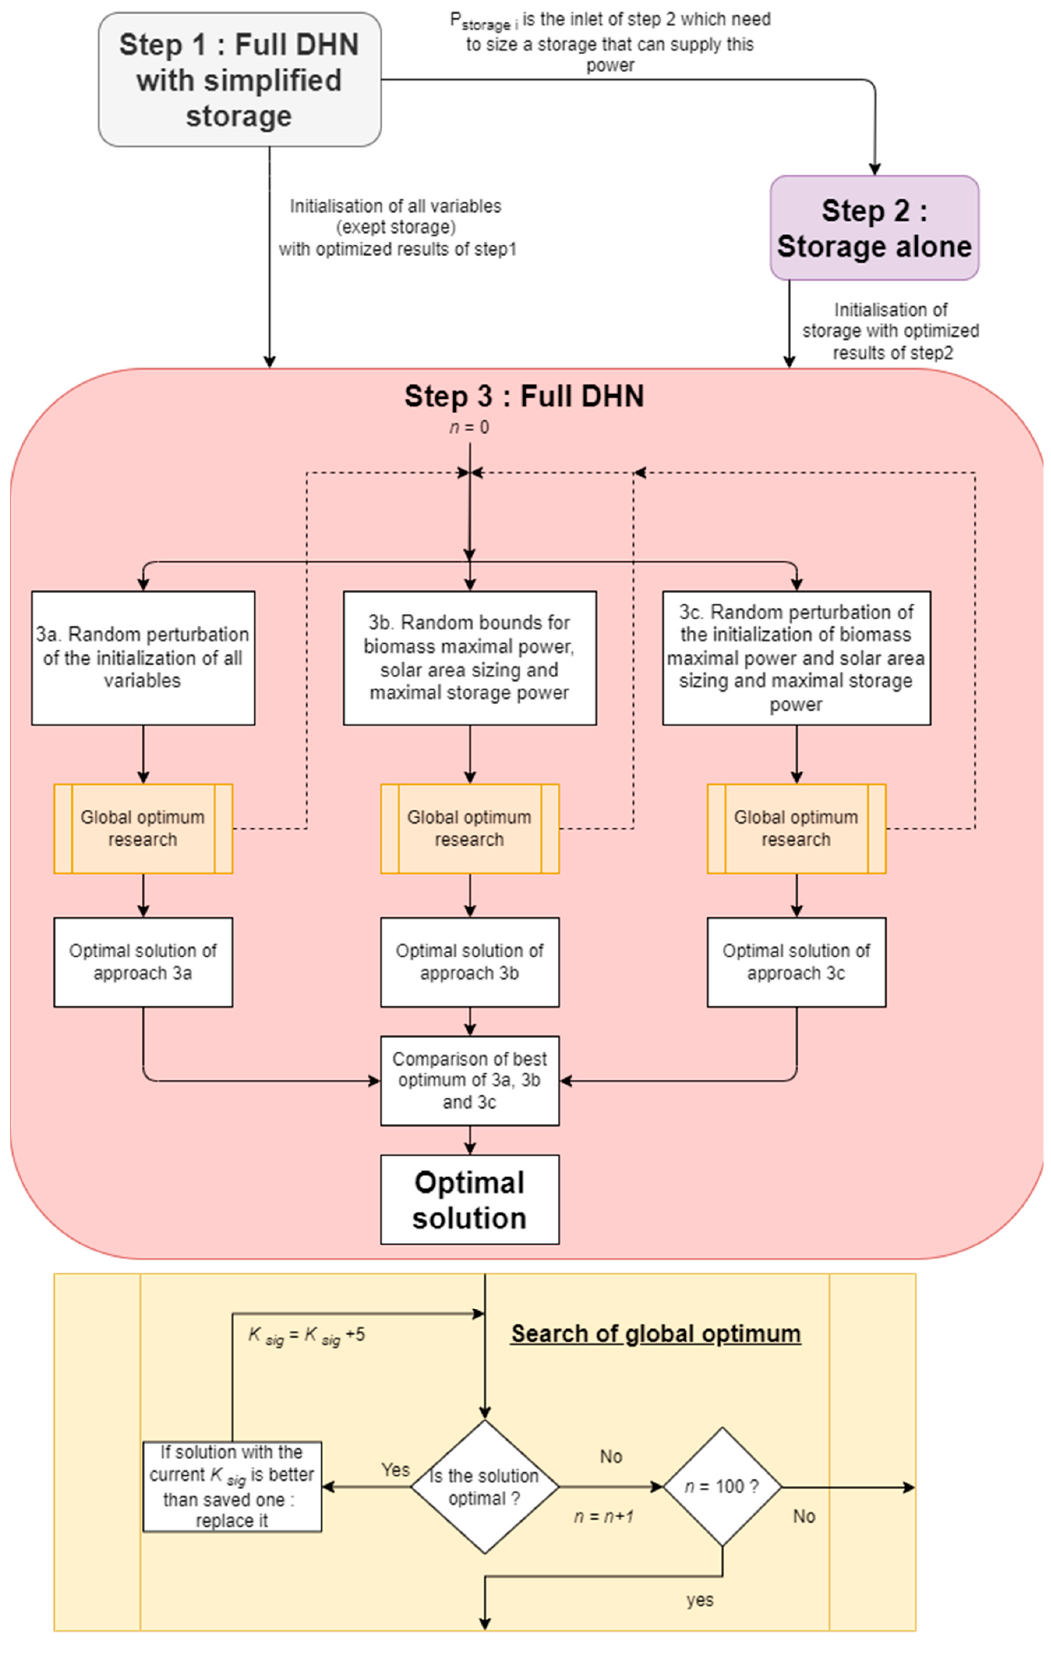
Figure 8. Schematic diagram of the initialization and resolution strategy to reach a reliable optimum.